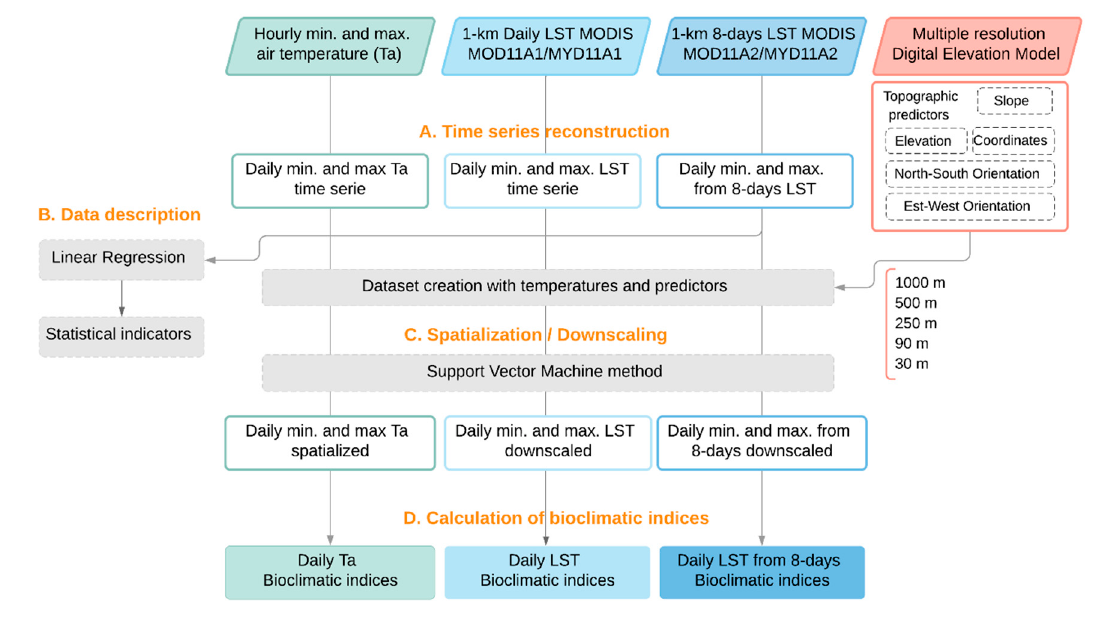
Figure 3. Flowchart of the general method used for data: air temperature (Ta), daily land surface temperature (LST) (MOD11A1/MYD11A1), weekly LST (MOD11A2/MYD11A2) and multiple resolutions of digital elevation models. ( A ) Times series reconstruction, ( B ) Data description, ( C ) Spatialization of air temperature and downscaling of LST, ( D ) Calculation of bioclimatic indices for the growing season.